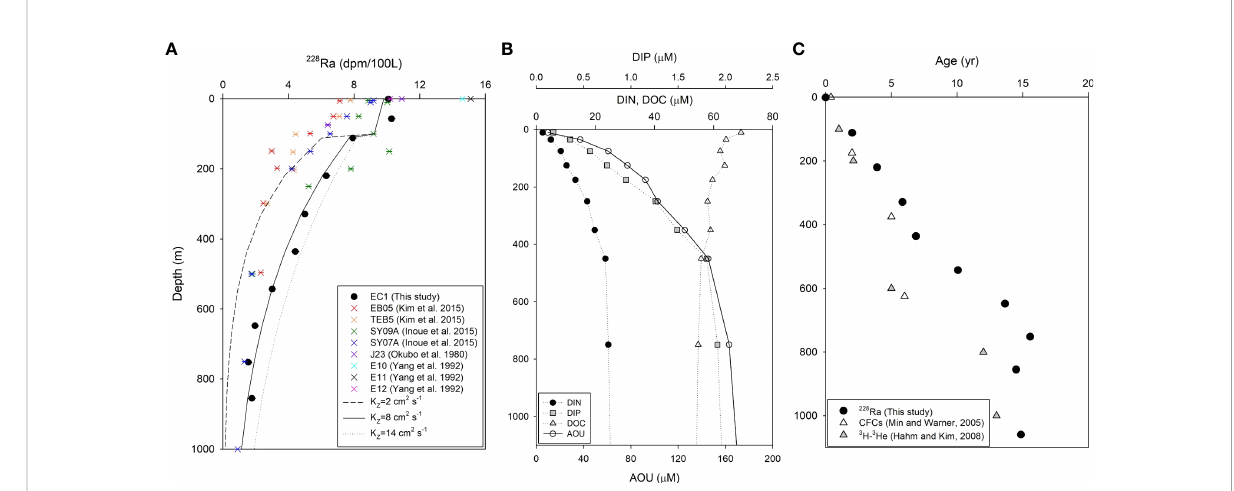
FIGURE 3 (A) Model estimates of K z fi tted to the 228 Ra pro fi les in the Ulleung Basin (UB). (B) Vertical pro fi les of apparent oxygen utilization (AOU), dissolved inorganic nitrogen (DIN) and phosphorus (DIP), and dissolved organic carbon (DOC) from 2006 to 2017 in the UB, East Sea. The dataset is available at the JOISS portal system (http://joiss.kr) which collects and provides marine research data in Korea. (C) Comparison of 228 Ra-ages (circles; this study), CFC-11/CFC-12 ratio ages (white triangle; Min and Warner, 2005) in the UB, and 3 H- 3 He ages in the Japan Basin (Hahm and Kim,